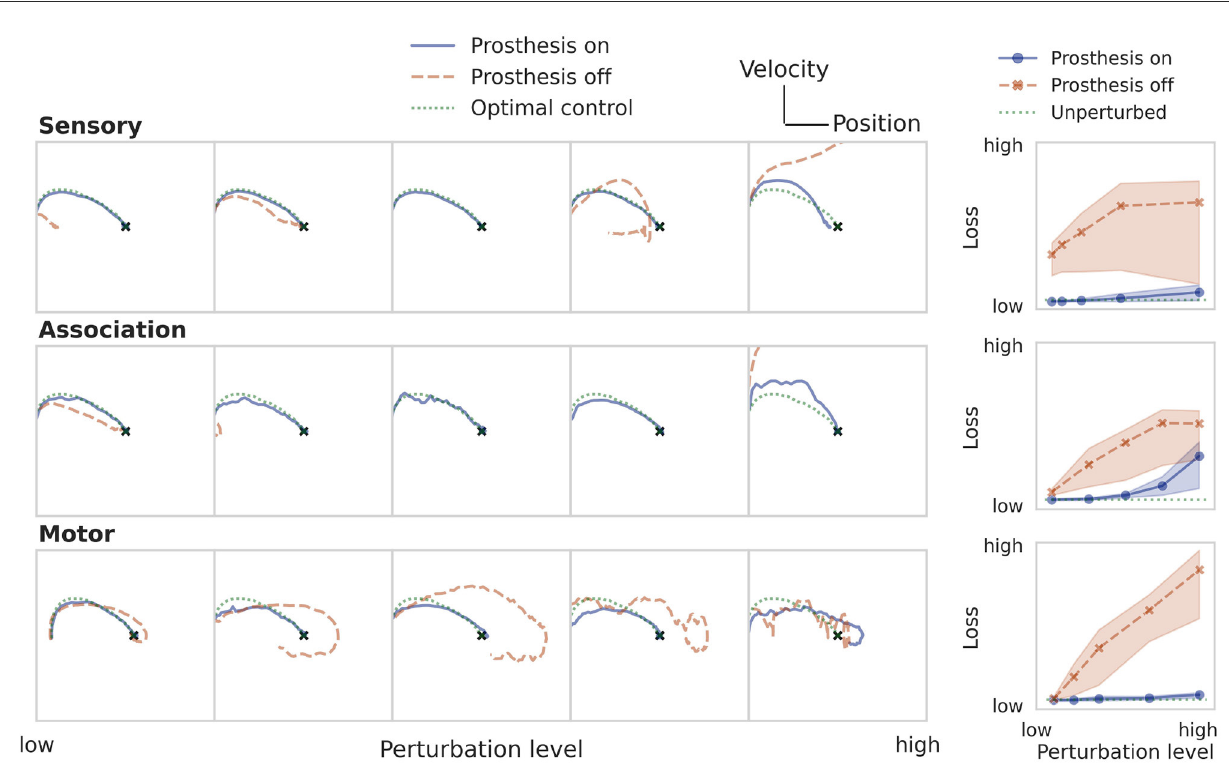
FIGURE5 Restoring particle stabilization performance by training a prosthetic controller directly on the LQR cost. The panels on the left show example trajectories at increasing perturbation strengths (from left to right). The rightmost column compares the loss of the system after training the prosthetic controller against the uncontrolled and unperturbed baselines. The three rows illustrate the case of an impaired sensory, association, or motor